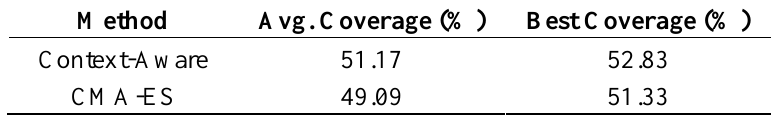
Figure 12. Coverage map of deploying 12 sensors using the context-aware method. Table 1. Results of Context-Aware and CMA-ES optimization